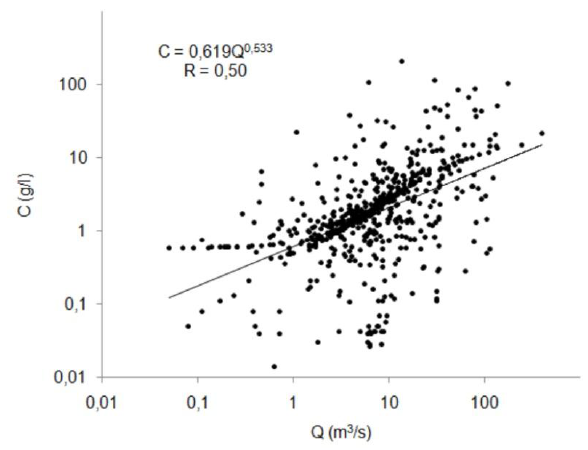
Figure 2: Scatter plot of water discharge (Q) versus sediment concentration (C)